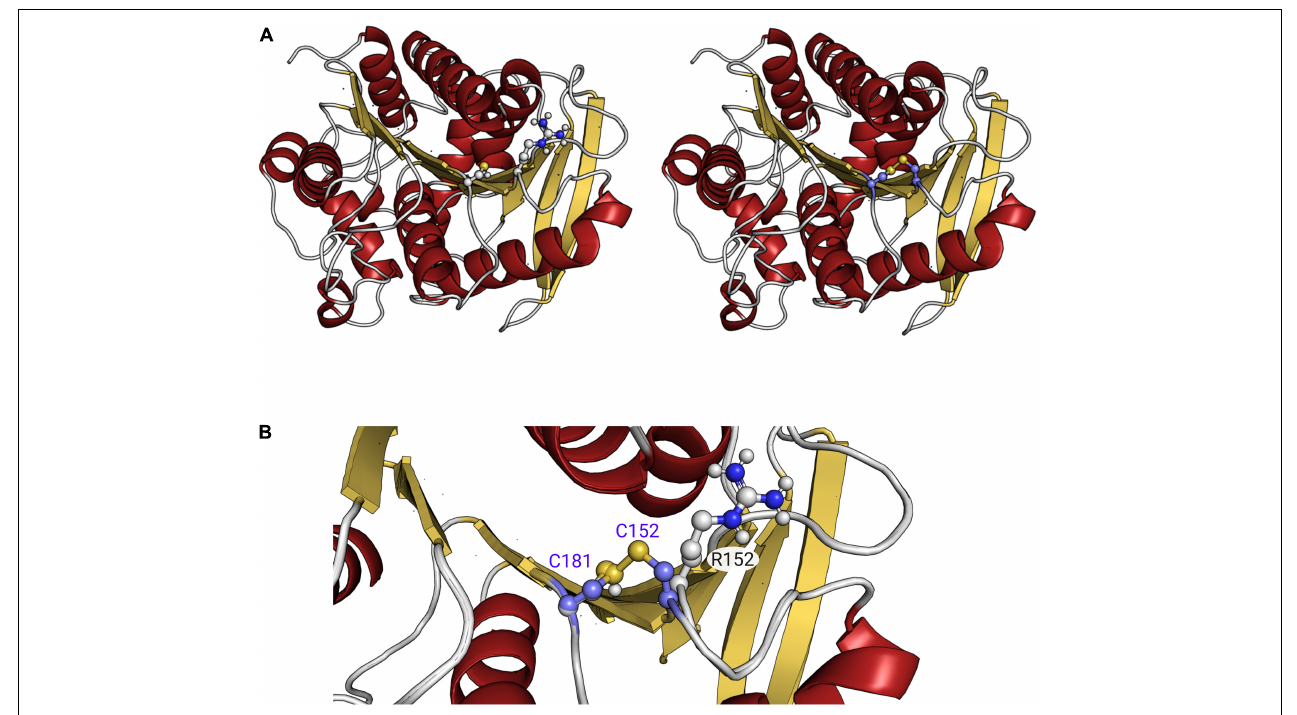
Adrio and Demain, 2014; Nchedo Ariole and George-West, 2020) and other polymers (Fütterer et al., 2004).